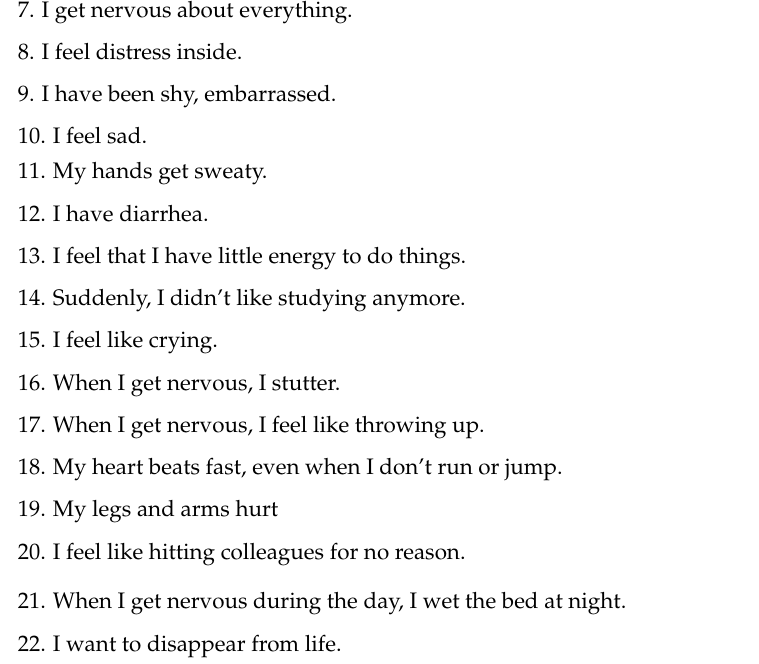
Table A2. Data collection instrument for the Infantile Stress Scale.